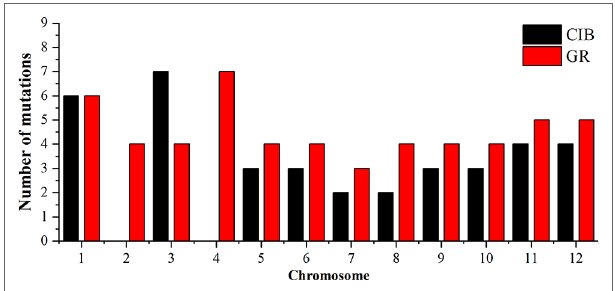
FIGURe 9 | MNVs on different chromosome induced by CIB irradiation and